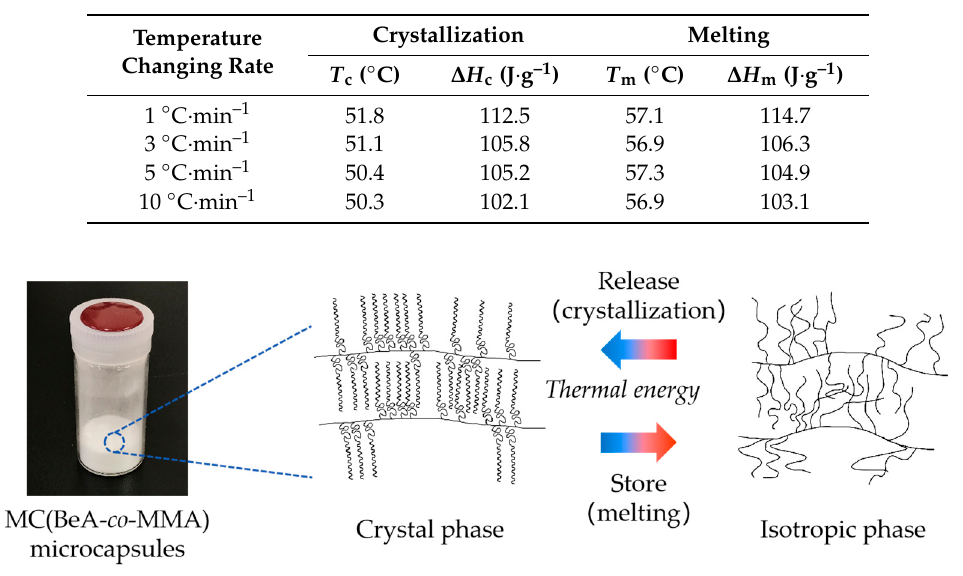
Figure 6. Schematic diagram of the phase transition behavior and crystal structure of MC(BeA- co - MMA) microcapsules with a crystalline n -behenyl side-chain.